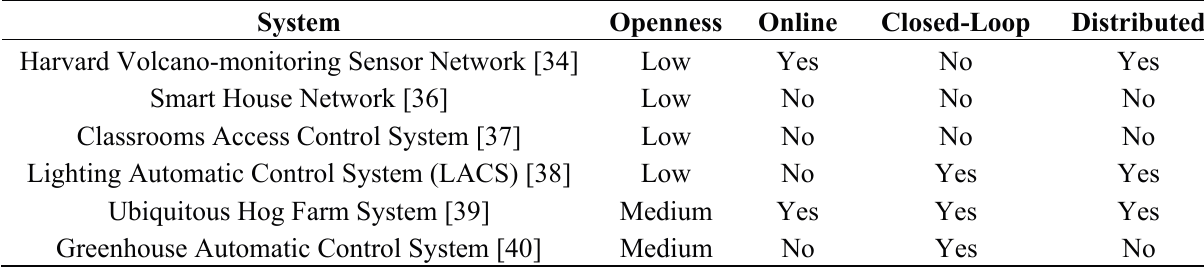
Table 1. Features of current control